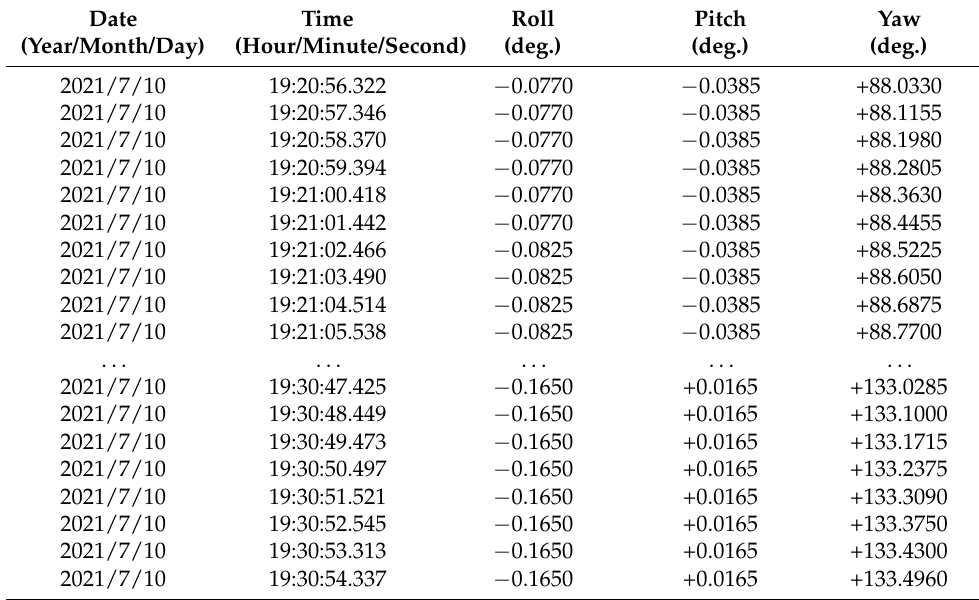
Table 3. The attitude data of HY2D satellite provided by NSOAS.